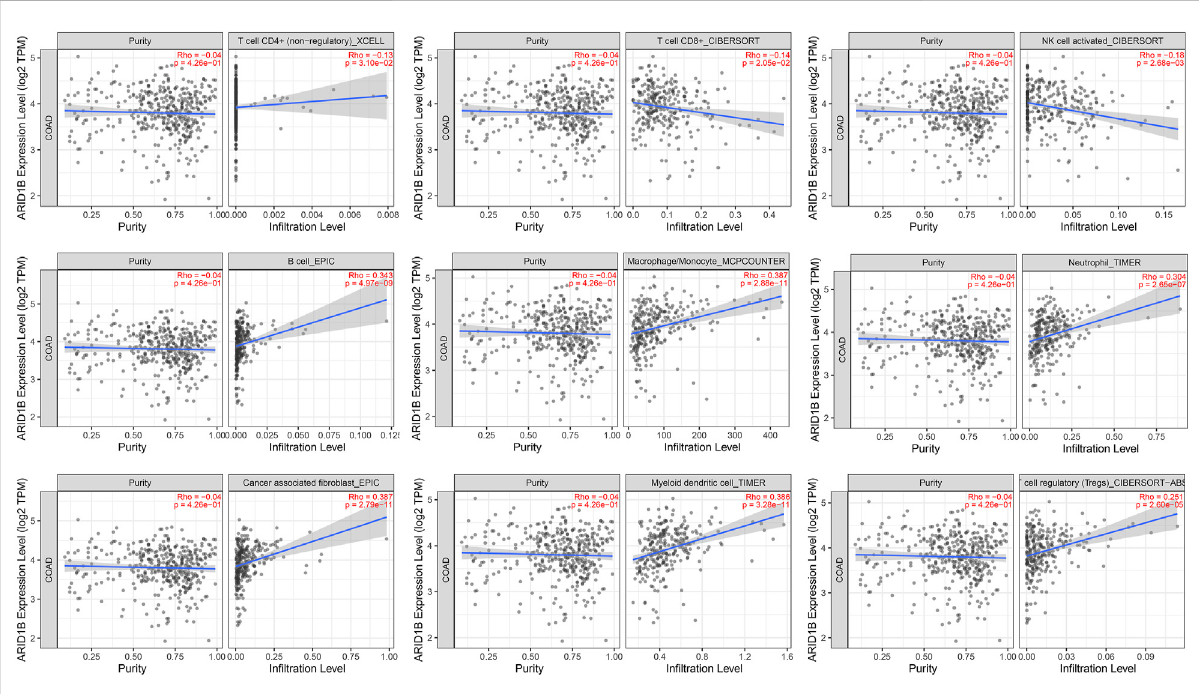
FIGURE 7 The correlation between ARID1B and immune cell in fi ltration. The signi fi cant negative-positive correlation between ARID1B and immune cell